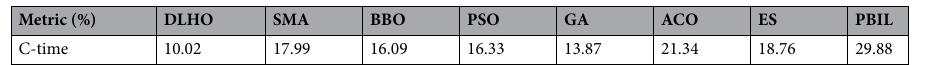
Table 12. Computational time of algorithms on second database for cancer detection.